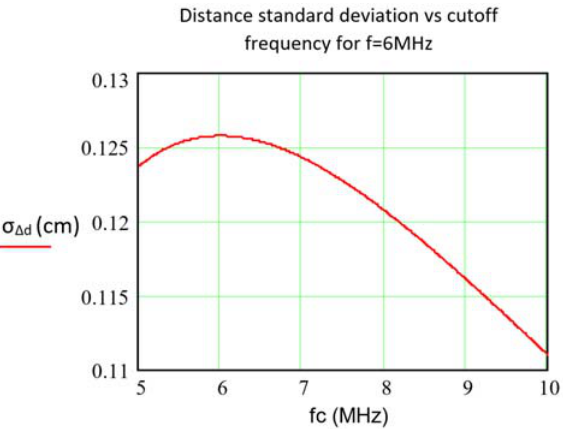
Figure 4. Standard deviation of distance error as a function of TIA cut-off frequency with f = 6 MHz, σ TC (Rf) = 10 ppm/°C, σ TC (Cf) = 30 ppm/°C and Δ T = +10 °C. Maximum value: σ d ( f = 6 MHz, fc = 6 MHz) = 0.126 cm.